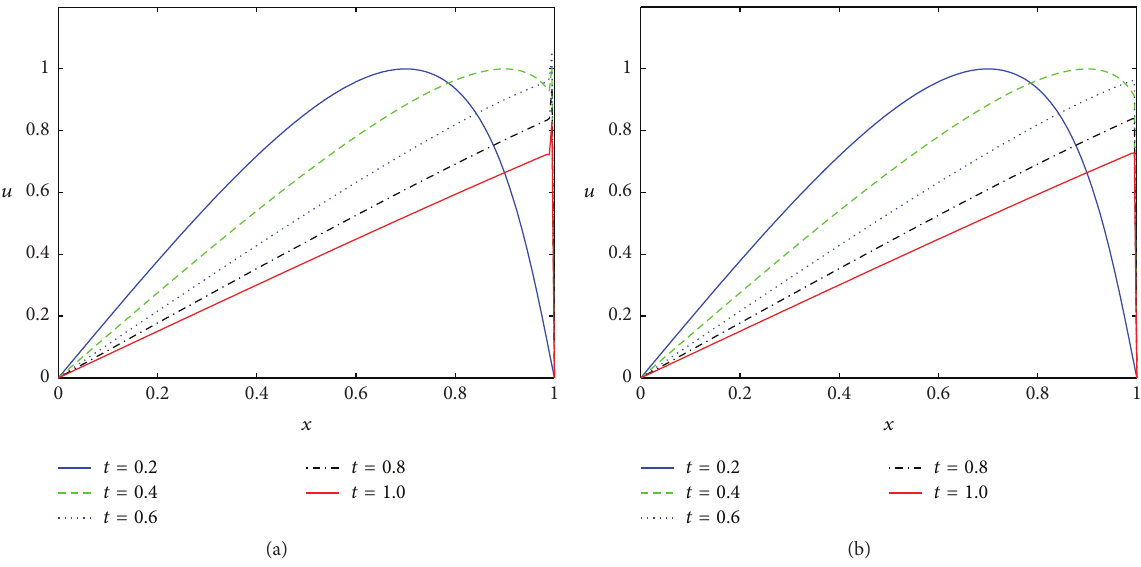
Figure 6: Effects of filtering for solving one-dimensional Burgers’ equation for Re = 10 4 by the VMEFG method. (a) is obtained without filter and (b) is with low-pass